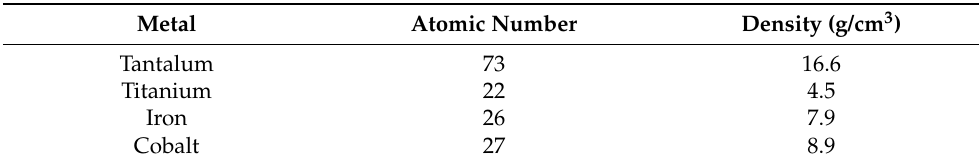
Table 2. Atomic number and density of some metals